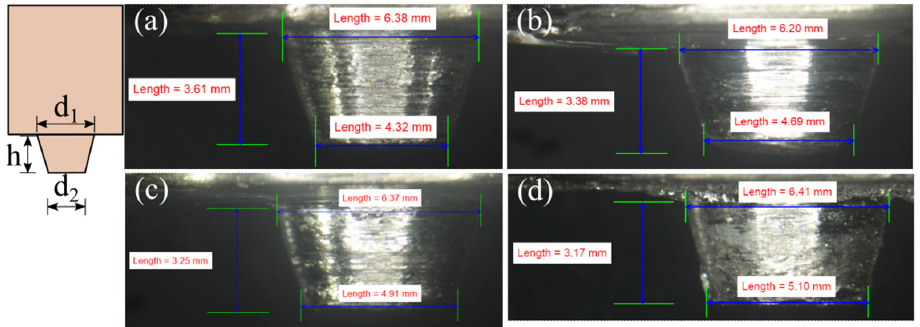
Figure 12. The progressive variation in the tool pin geometry when welding at 900 rpm and traverse speeds of ( a ) the initial tool under a no-weld condition, and under ( b ) 30, ( c ) 60, and ( d ) 90 mm/min.